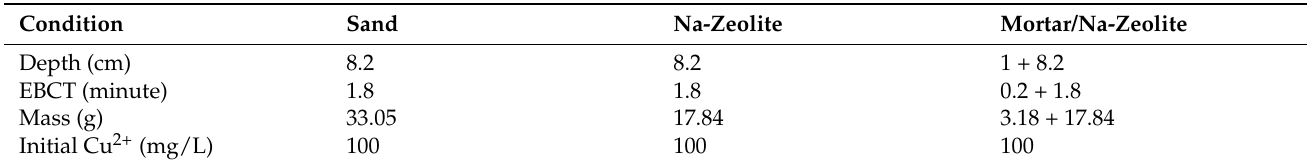
Table 1. Experimental conditions for continuous Cu 2+ removal.